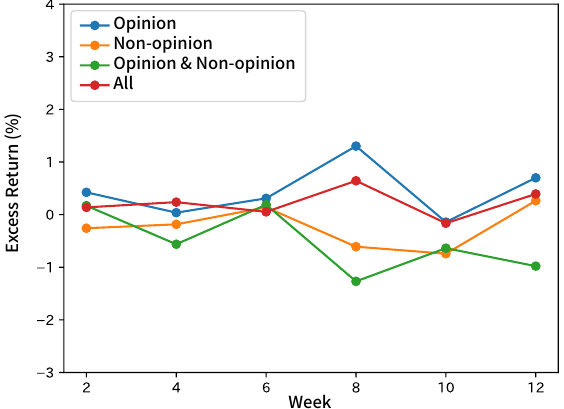
Figure 8. Excess returns of Broker E in forecasting analyst net income estimates.